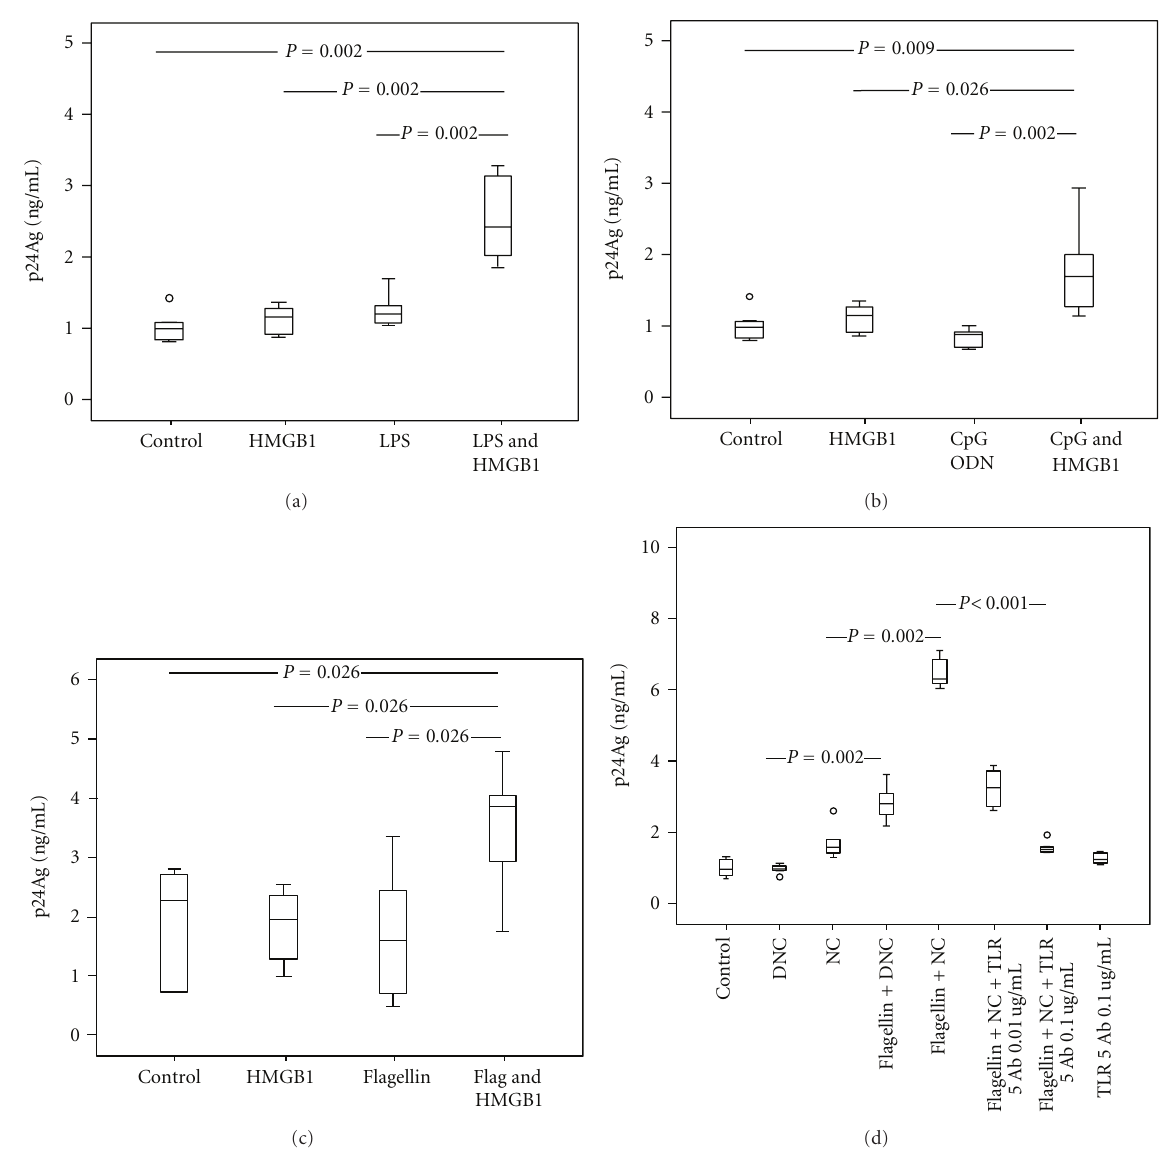
Figure 3: Interacting e ff ect of recombinant HMGB1 and TLR-ligand complexes in U1 cells. Inhibition of flagellin complexes induced HIV-1 replication by anti-TLR5 antibodies. U1 cells were stimulated with recombinant HMGB1 (1 μ g/mL) and TLR ligands: LPS 10ng/mL (a), CpG-ODN 1 μ g/mL (b) and flagellin 10ng/mL (c) alone or in complexes. (d) U1 cells were incubated with 0.1 and 0.01 ug/mL anti-TLR5 antibodies (TLR5 Ab) for 1 hour and then exposed to necrotic extract (NC) and HMGB1-depleted necrotic extract (DNC), alone or in complexes with flagellin (10ng/mL). HIV-1 replication was estimated after 48 hours of incubation. A dose-dependent inhibition of flagellin- necrotic extract complexes stimulatory e ff ect is present in wells pretreated with anti-TLR5 antibodies ( P for trend < 0.001). Results from three independent experiments in duplicates are